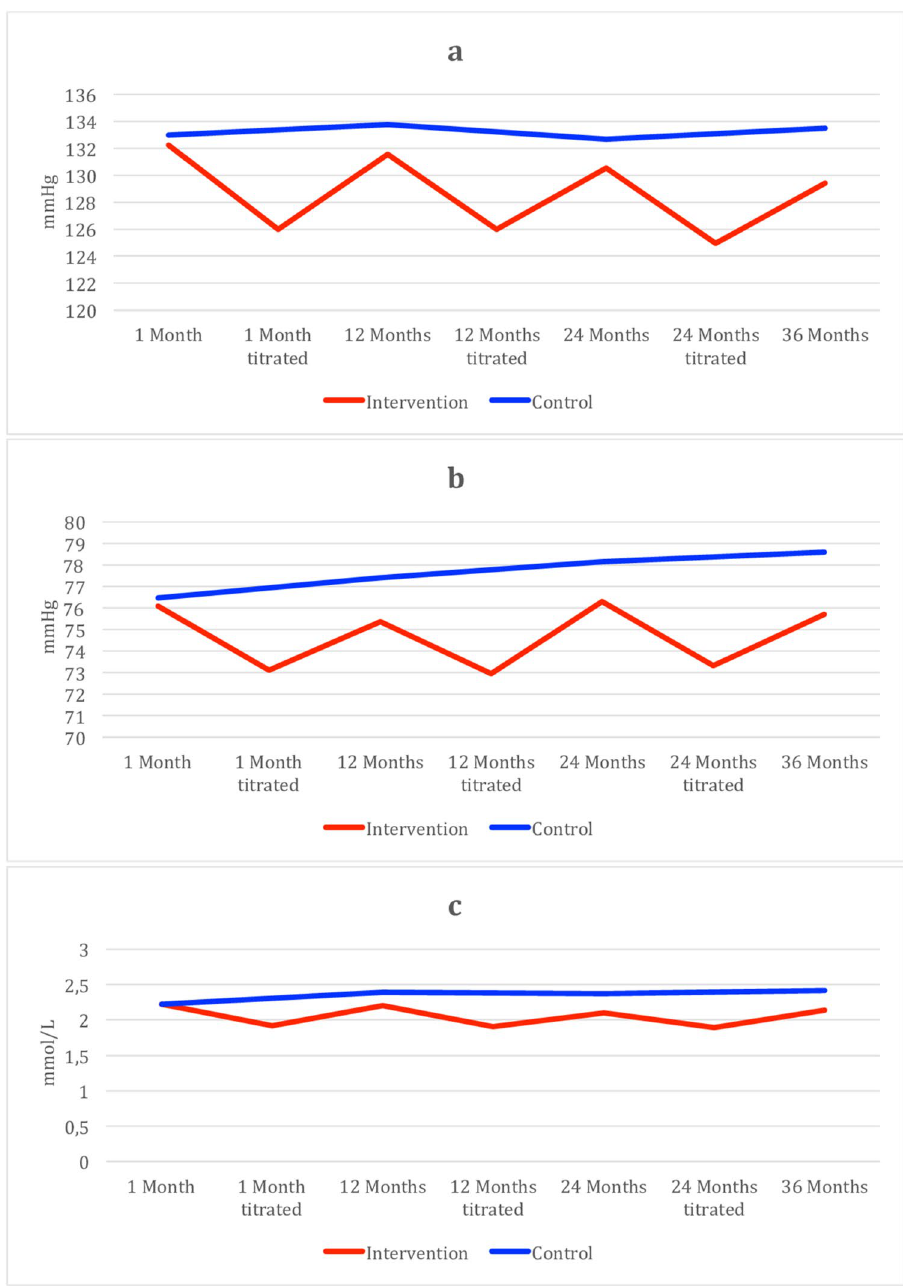
cholesterol. Means adjusted for type of ACS and